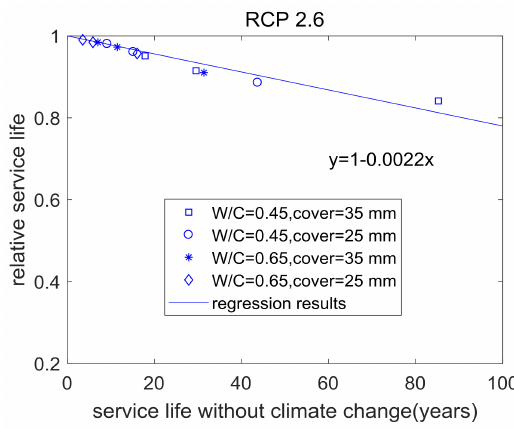
Figure 16. Relative service life of cracked concrete-RCP 2.6, time slice 2000.